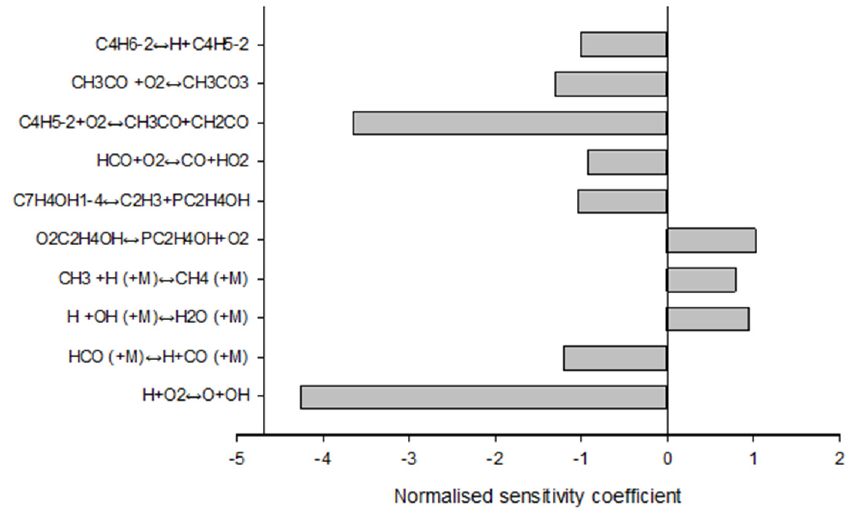
Figure 5. Sensitivity analysis for the laminar burning velocity of the stoichiometric ethanol-air mixture at atmospheric pressure and the initial temperature (310 K).